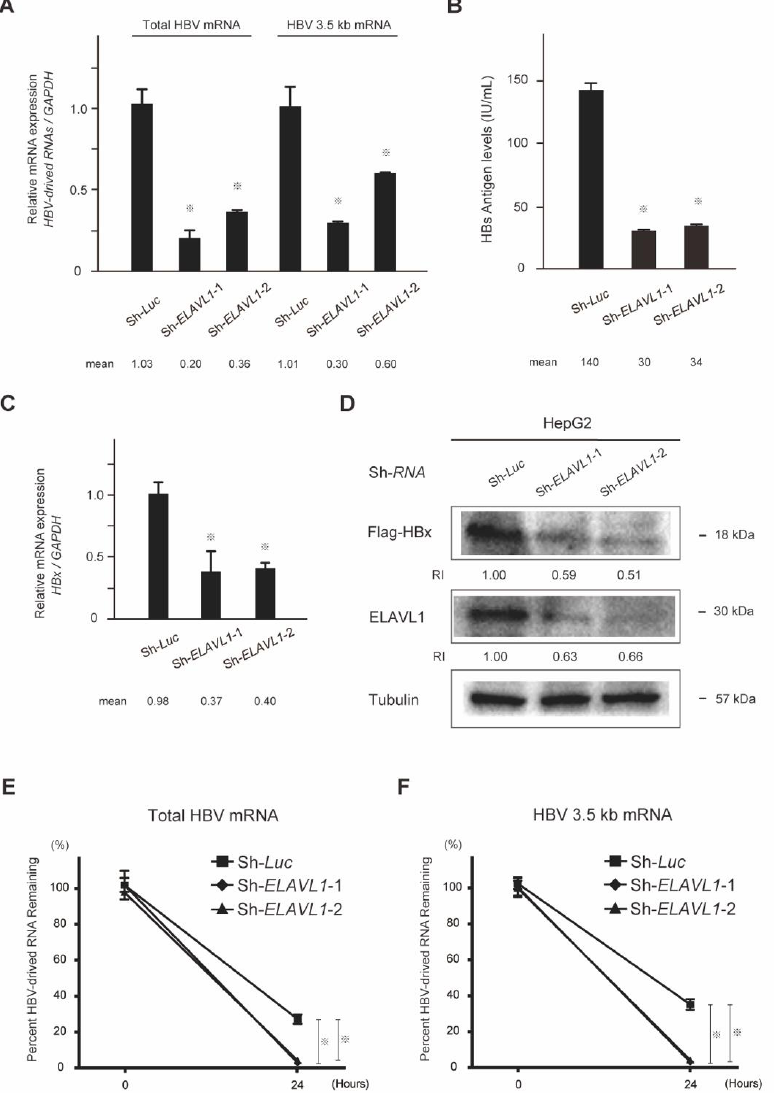
Figure 2. ELAVL1 -knockdown assays in HCC cells. ( A ) Total HBV mRNA and 3.5 kb mRNA levels of ELAVL1 -knockdown HepAD38 cells in the absence of tetracycline were determined via quantitative real-time PCR analyses. Data represent the mean with SD of triplicate experiments (Student’s t -test, ※ p < 0.05). ( B ) Supernatants derived from ELAVL1 -knockdown HepAD38 cells in the absence of tetracycline were subjected to CLEIA for HBs antigen measurement. Data represent the mean with SD of triplicate experiments (Student’s t -test, ※ p < 0.05). ( C ) ELAVL1 -knockdown HepG2 cells were subjected to quantitative real-time PCR analyses for HBx mRNA expression. Data represent the mean with SD of triplicate experiments (Student’s t -test, ※ p < 0.05). ( D ) ELAVL1 -knockdown HepG2 cells that constitutively express Flag-HBx protein were subjected to Western blot analyses using anti-Flag, anti-ELAVL1, and anti-tubulin antibodies (loading control). RIs were determined by normalizing band intensities to those of internal controls. ( E ) Quantitative real-time PCR analyses of total HBV mRNA relative to GAPDH in ELAVL1 -knockdown HepAD38 cells. RNA was harvested at 0 and 24 h post tetracycline treatment and relative levels of remaining total HBV mRNA were analyzed. Data represent the mean with SD of triplicate experiments (Student’s t -test, ※ p < 0.05). ( F ) Quantitative real-time PCR analyses of total 3.5 kb mRNA relative to GAPDH in ELAVL1 -knockdown HepAD38 cells. RNA was harvested at 0 and 24 h post tetracycline treatment and relative levels of remaining 3.5 kb mRNA were analyzed. Data represent the mean with SD of triplicate experiments (Student’s t -test, ※ p <